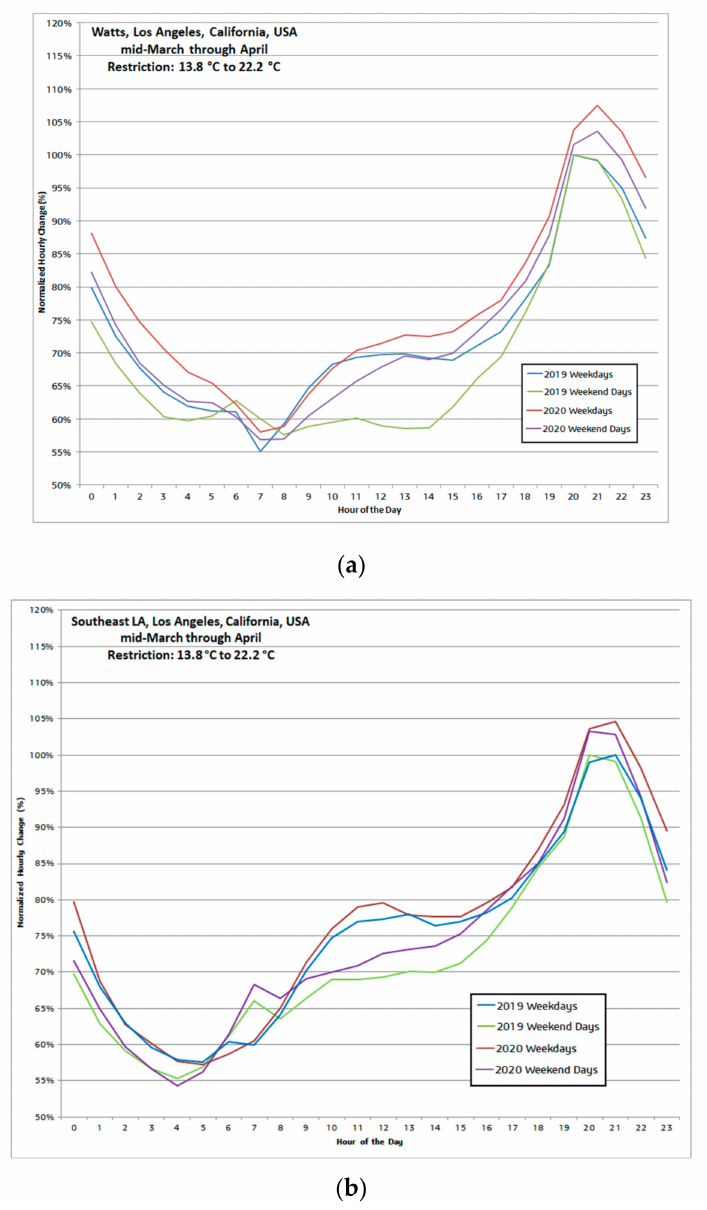
Figure 9. Baseline peak normalized (separately for weekdays and weekends) energy use change comparing 2020 to 2019 baseline for mid-March through April using a temperature restriction. Examples presented for ( a ) Feeder A and ( b ) Feeder B within the LA Basin microclimatic